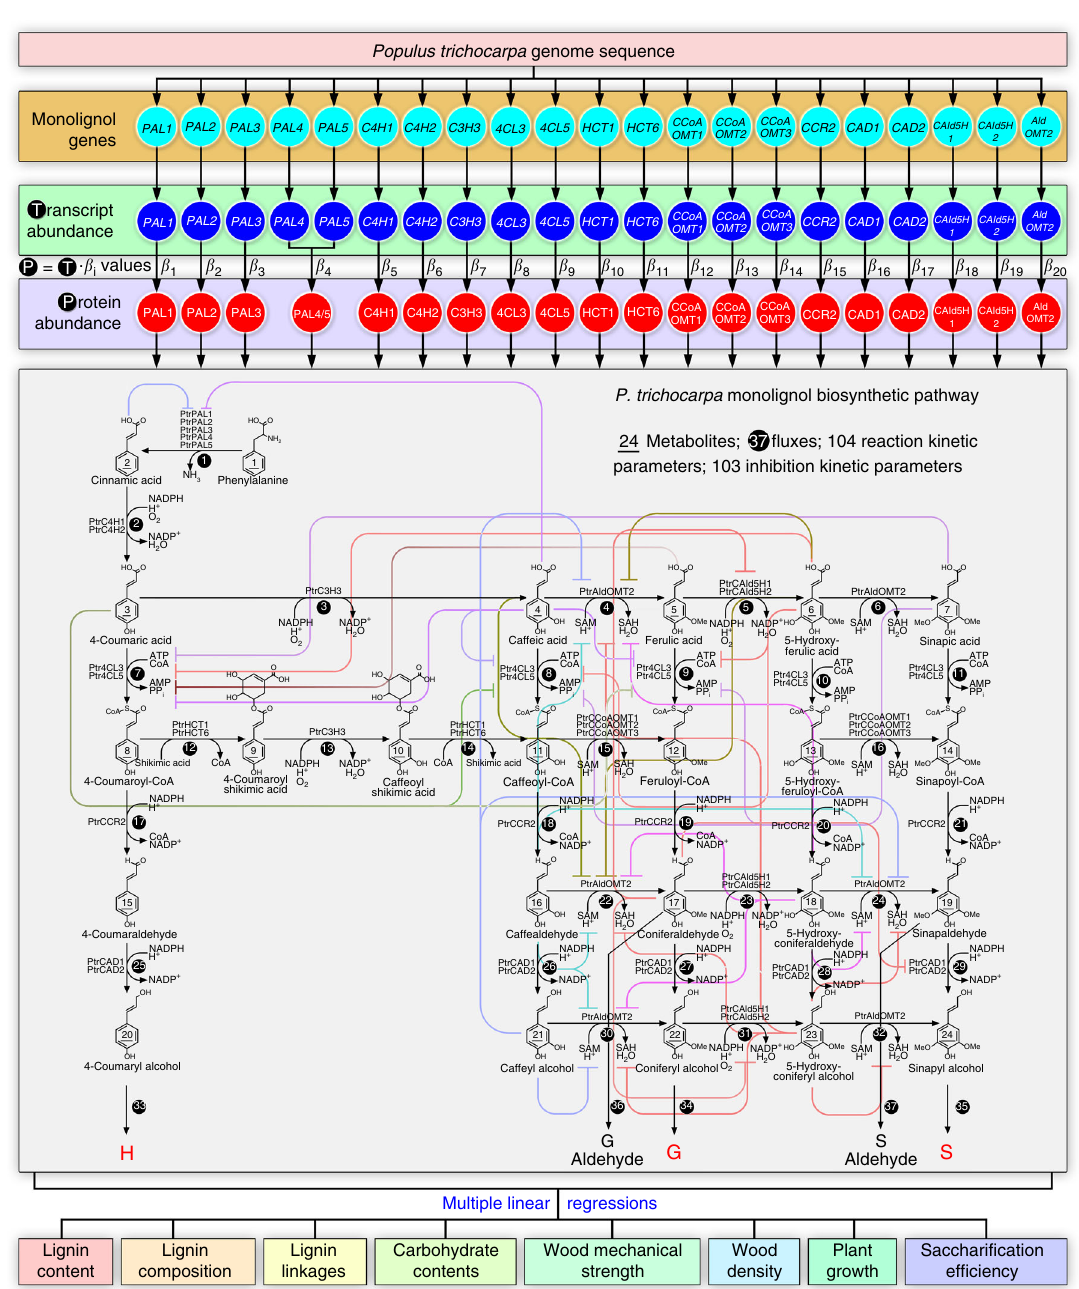
Fig. 1 Our multi-omics integrative analysis of the monolignol biosynthetic pathway in P. trichocarpa predicts wood properties for wood utilization. The pathway is represented by 21 monolignol genes (turquoise circles) identi fi ed from the genome sequence, and their corresponding transcripts (blue circles) and proteins (red circles). The gene transcript abundances can be converted to protein abundances by speci fi c β i values from linear regression models (Supplementary Table 2). The monolignol proteins in a metabolic grid convert phenylalanine to monolignols in stem-differentiating xylem. The metabolic grid consists of 24 metabolites (underlined numbers within structures), 37 reaction fl uxes (white numbers on black circles), 104 reaction kinetic parameters and 103 inhibition kinetic parameters. Other enzymes, regulators, and components are involved but genes encoding these factors are unknown or not yet suf fi ciently characterized to be included in this study. Fluxes 16, 20, 21, and 26 were set to zero because kinetic parameters for these reactions are not currently available. Colored lines represent pathway enzyme inhibitions. Multiple linear regressions predict the lignin and wood properties. Abbreviations: Reduced nicotinamide adenine dinucleotide phosphate (NADPH), oxidized nicotinamide adenine dinucleotide phosphate (NADP + ), coenzyme A (CoA), adenosine triphosphate (ATP), adenosine monophosphate (AMP), pyrophosphate (PPi), S-adenosylmethionine (SAM), S- adenosylhomocysteine